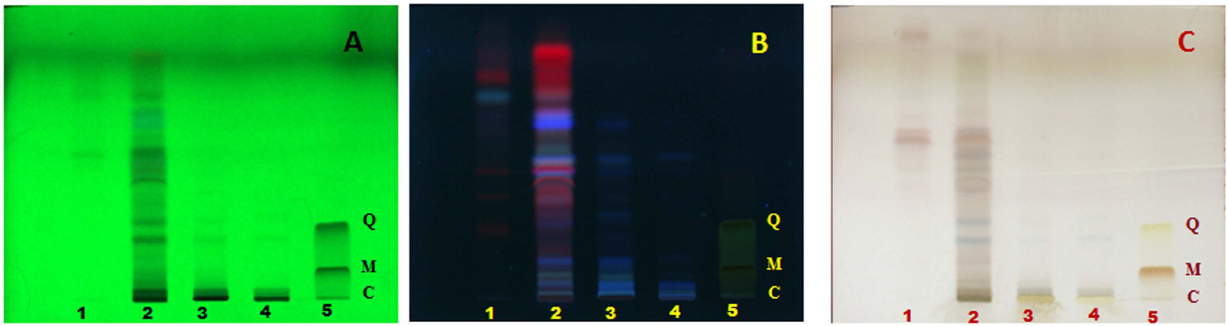
Figure 9. HPTLC fingerprint of extracts of G.glauca stem. (1) Petroleum ether extract, (2) Ethyl acetate extract, (3) Methanol extract, (4) Ethanol extract (70% v/v) at (A) 254 nm, (B) 366 nm and (C) 600 nm. Standards used are quercetin (Q), myricetin (M) and catechin (C) in lane 5.